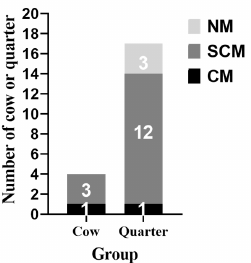
Figure 2. Cow and quarter level infection status. CM: Clinical mastitis, SCM: Subclinical mastitis, NM: No mastitis. 3.2. Number of S. Aureus Count (CFU/Ml) in the Mammary Secretion The mean number of S. aureus count in mammary secretion ranged from 1.3 × 10 4 CFU/mL to 1.4 x 10 5 CFU/ mL at day 1 and 10 of challenge, respectively (Figure 3). All infected quarters shed SAUT2 strain as confirmed by pulsed-field gel electrophoresis results (Figure 4). Bacteriological culture results of milk samples collected at calving (C) and three days after parturition (C+3) was negative for challenge strain of S. aureus indicating that post experimental treatment at Ch+15 with antibiotic cleared the infection.